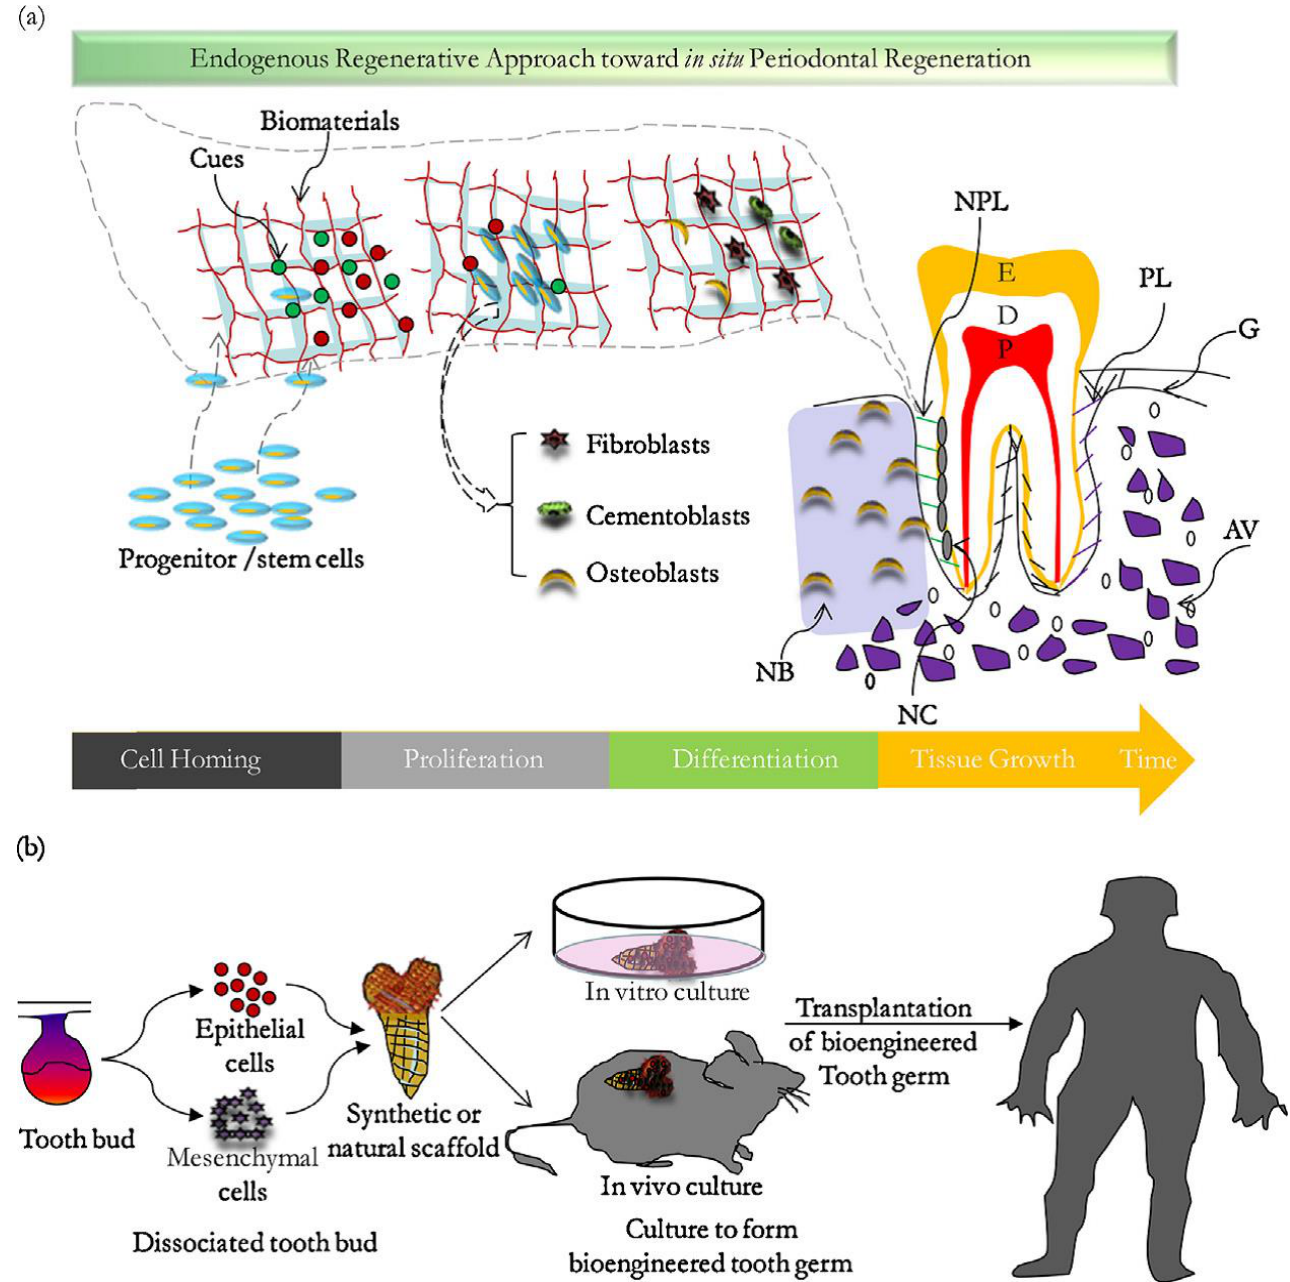
Figure 1. ( a ) Schematic diagram of the endogenous method for periodontal tissue regeneration. E: enamel, D: dentin, P: pulp, G: gum, PL: periodontal ligament, AB: alveolar bone, NPL: new periodontal ligament, NB: new bone, NC: new bone cement. ( b ) Strategies for designing complete teeth [16].